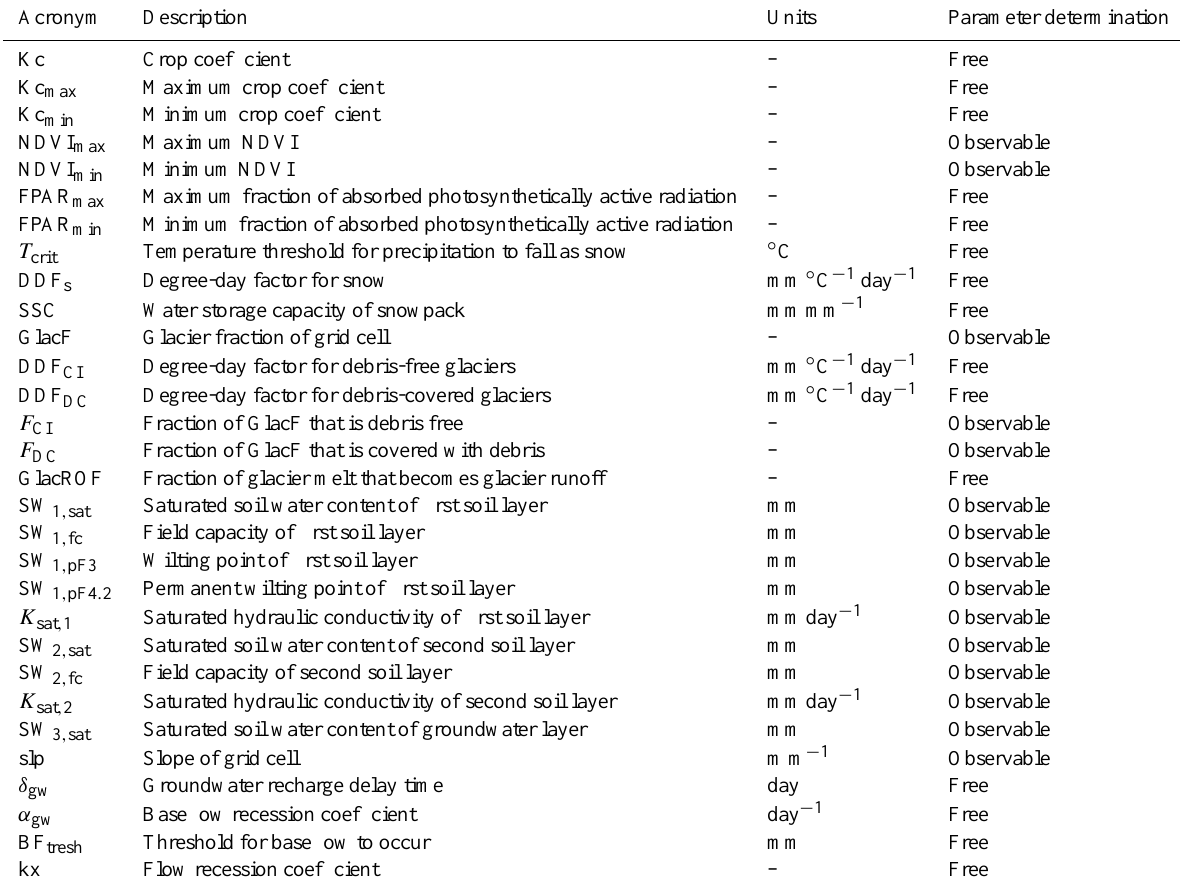
Table A1. Overview of SPHY model parameters. The last column indicates whether the parameter is observable, or can be determined by calibration